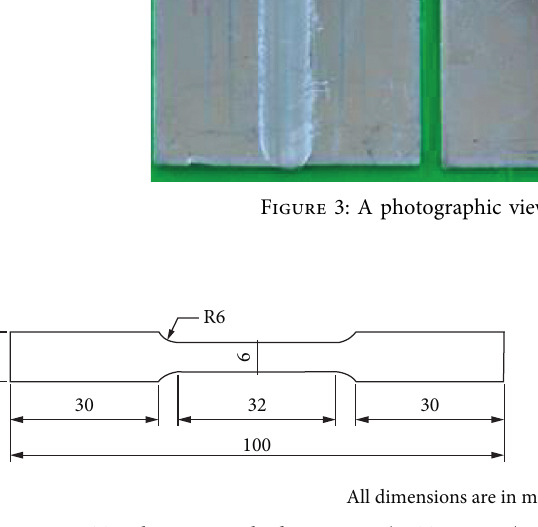
Figure 4: Tensile test sample dimensions (ASTM-E8-04). Table 6: Mechanical behaviors of welded joints. Sample